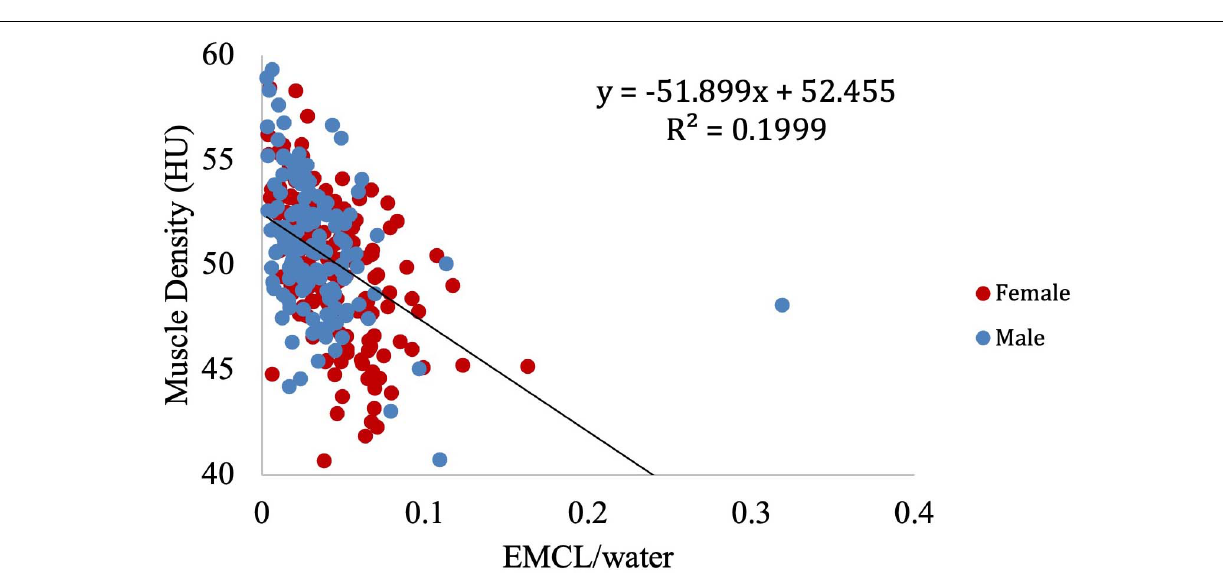
FIGURE 5 | Relationship between muscle density from CT and EMCL/water ( p <